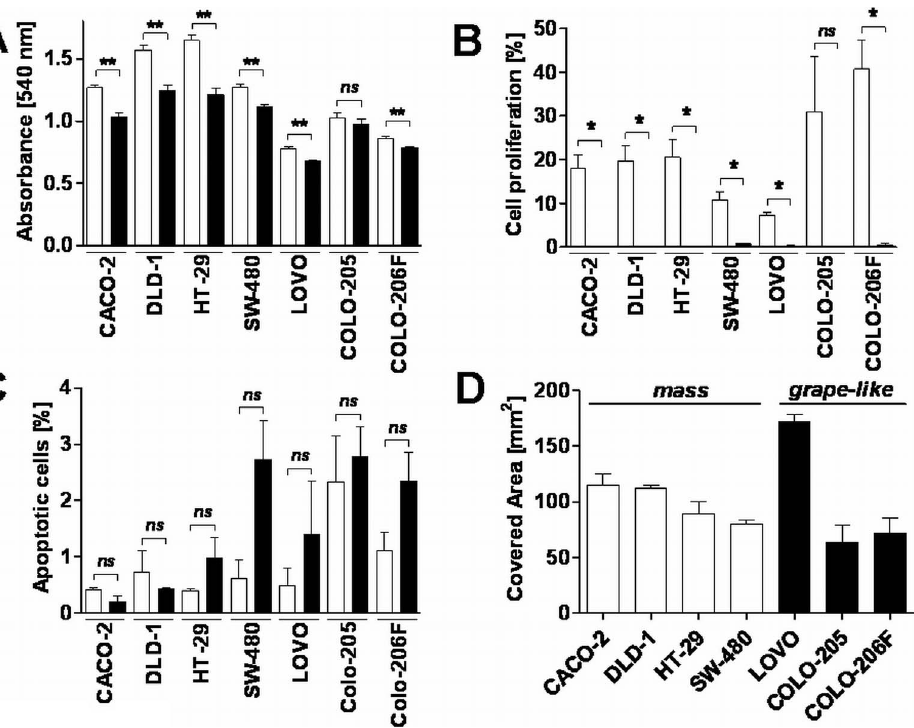
Figure 2. The influence of lrECM microenvironment on cell proliferation, apoptosis and cell migration in CRC cell lines. Cells were cultivated under 2D or 3D conditions. A) Cell viability was measured 48 h later using the MTT assay. Values represent the mean absorbance at 540 nm 6 SD of triplicates. White bars represent cells cultured on plastic (2D); black bars cells cultured on lrECM (3D). Two-tailed P -values were calculated by the Mann-Whitney-U test (** indicates a P -value , 0.001; ns=not significant). B) Cell proliferation was quantified by calculation of the percentage of cells with BrdU incorporation and the total number of DAPI-positive cells per field (at least three randomly selected fields per coverslip). The data presented are the mean 6 SD from three replicates. White bars represent cells cultured on plastic (2D); black bars cells cultured on lrECM (3D). Two-tailed P -values were calculated by the paired t-test (* indicates a P -value , 0.05; ns=not significant). C) The percentage of apoptotic cells was calculated as the ratio of DAPI-positive cells with fragmented nuclei and all DAPI-positive cells. The data presented are the mean 6 SD from three replicates.White bars represent cells cultured on plastic (2D); black bars cells cultured on lrECM (3D). Two-tailed P -values were calculated by the paired t-test (ns=not significant). D) Migration of CRC cell lines was quantified using the fence assay. Data represent means 6 SD of three independent experiments. White bars represent cell lines classified as mass type; black bars the grape-like class.